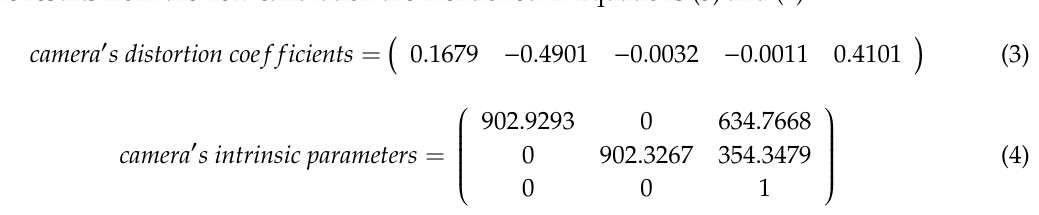
Figure 9. The calibration with a Liquid-crystal display. The results from the new calibration are mentioned in Equations (3) and